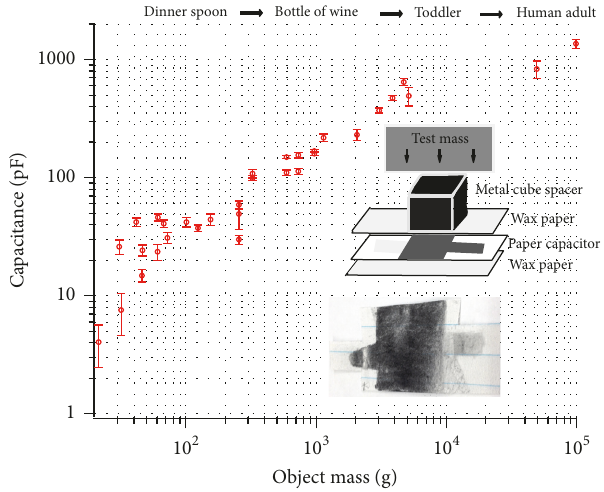
Figure 4: Plot of measured capacitance change versus applied mass for the pencil-on-paper force sensor. Error bars represent 95% confidence intervals. The capacitance noted represents the change in capacitance after tare when no mass was applied.